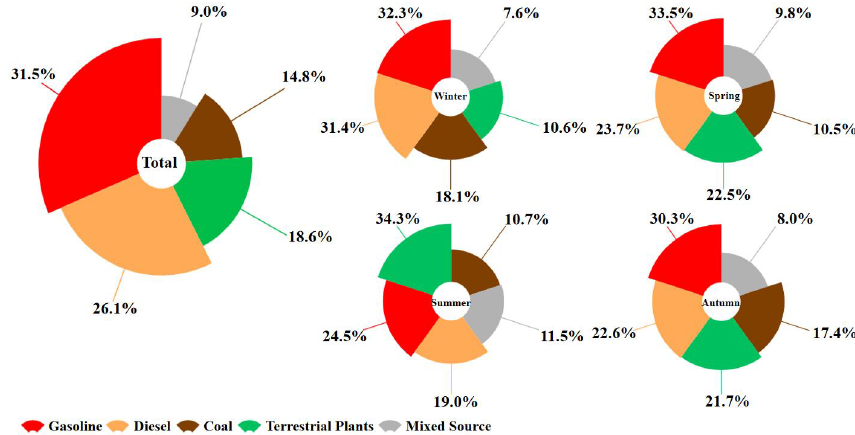
Figure 8. Sources and contributions of particulate-bound n -alkanes in